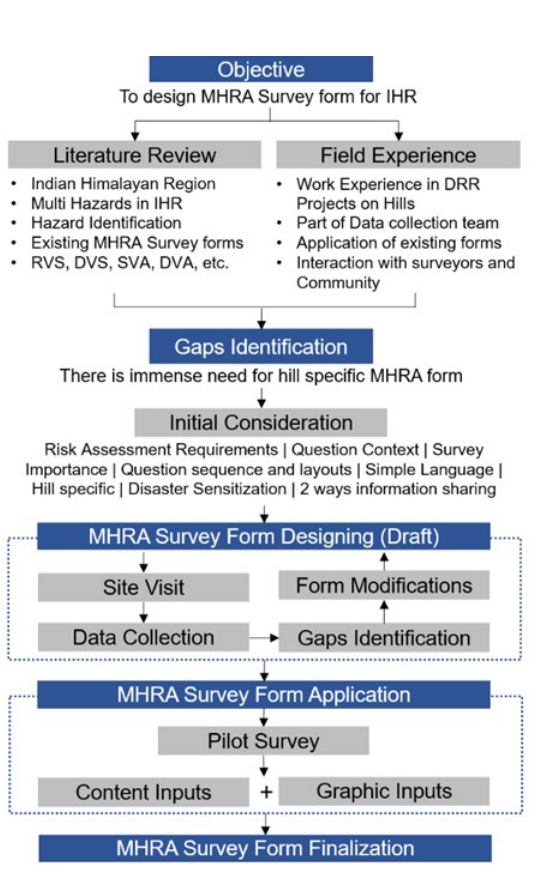
Figure 2. Methodology adopted by the author.